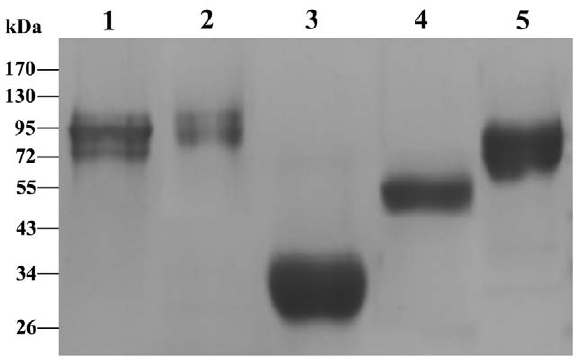
Figure 1. SDS-PAGE profile of semi-purified antigens from five parasites confirmed as food-borne helminthiases. Lanes 1 to 5 represent the semi-purified antigens with the molecular weight of 95, 98, 35, 55 and 90 kDa from C. cellulosae , A. cantonensis , P. westermani , T. spiralis and Spirometra plerocercoids, respectively.